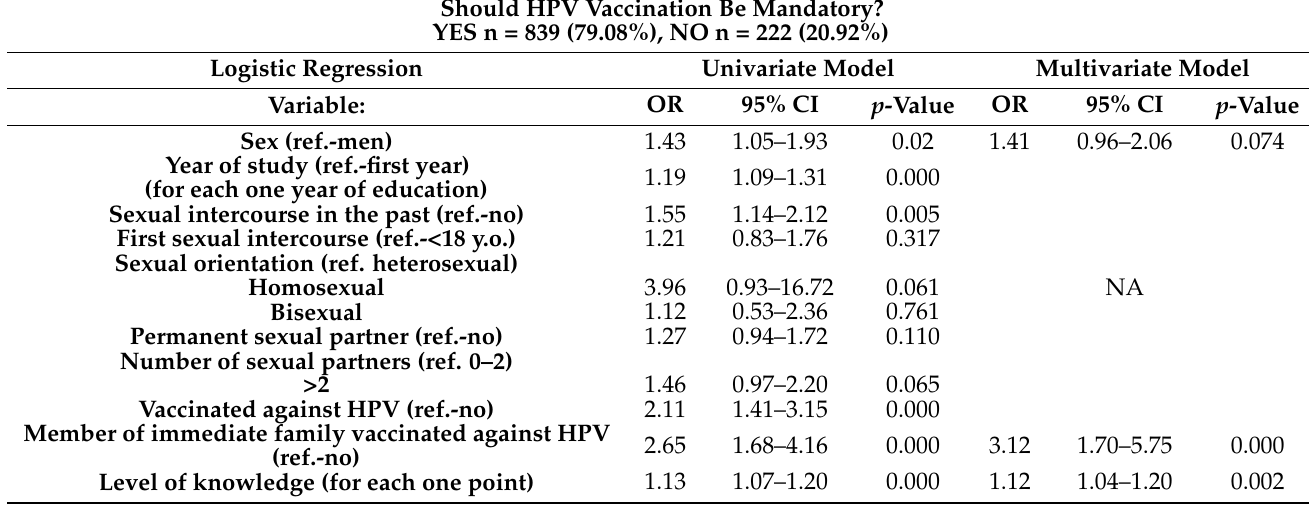
Table 3. Factors influencing medical students’ opinions about mandatory HPV vaccination (univariate and multivari- ate model).